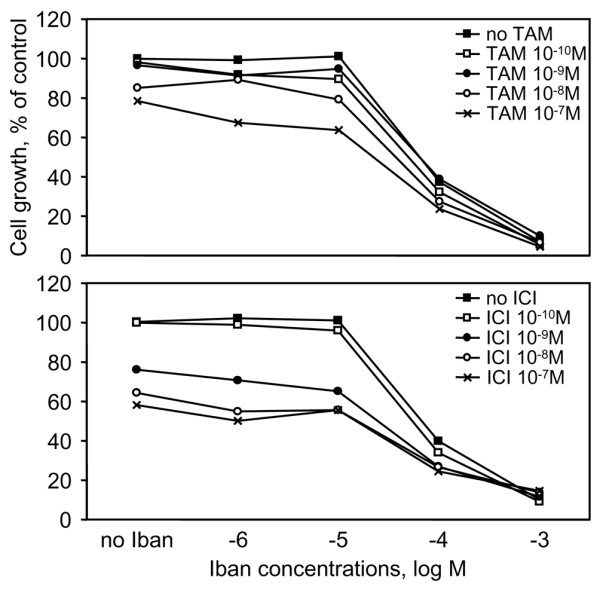
Dose-response curves of ibandronate (Iban from 10-6 to 10-3 M) in combination with increasing concentrations of 4-hydroxytamoxifen (TAM from 10-10 to 10-7 M) or ICI 182,780 (ICI from 10-10 to 10-7 M). MCF-7 cells were incubated for 72 hours. Cell proliferation was determined by crystal violet staining assay. Data are presented as percentages of control values (mean) and were used for combination index calculations (see Table 2). Experiments were performed three times in replicate.